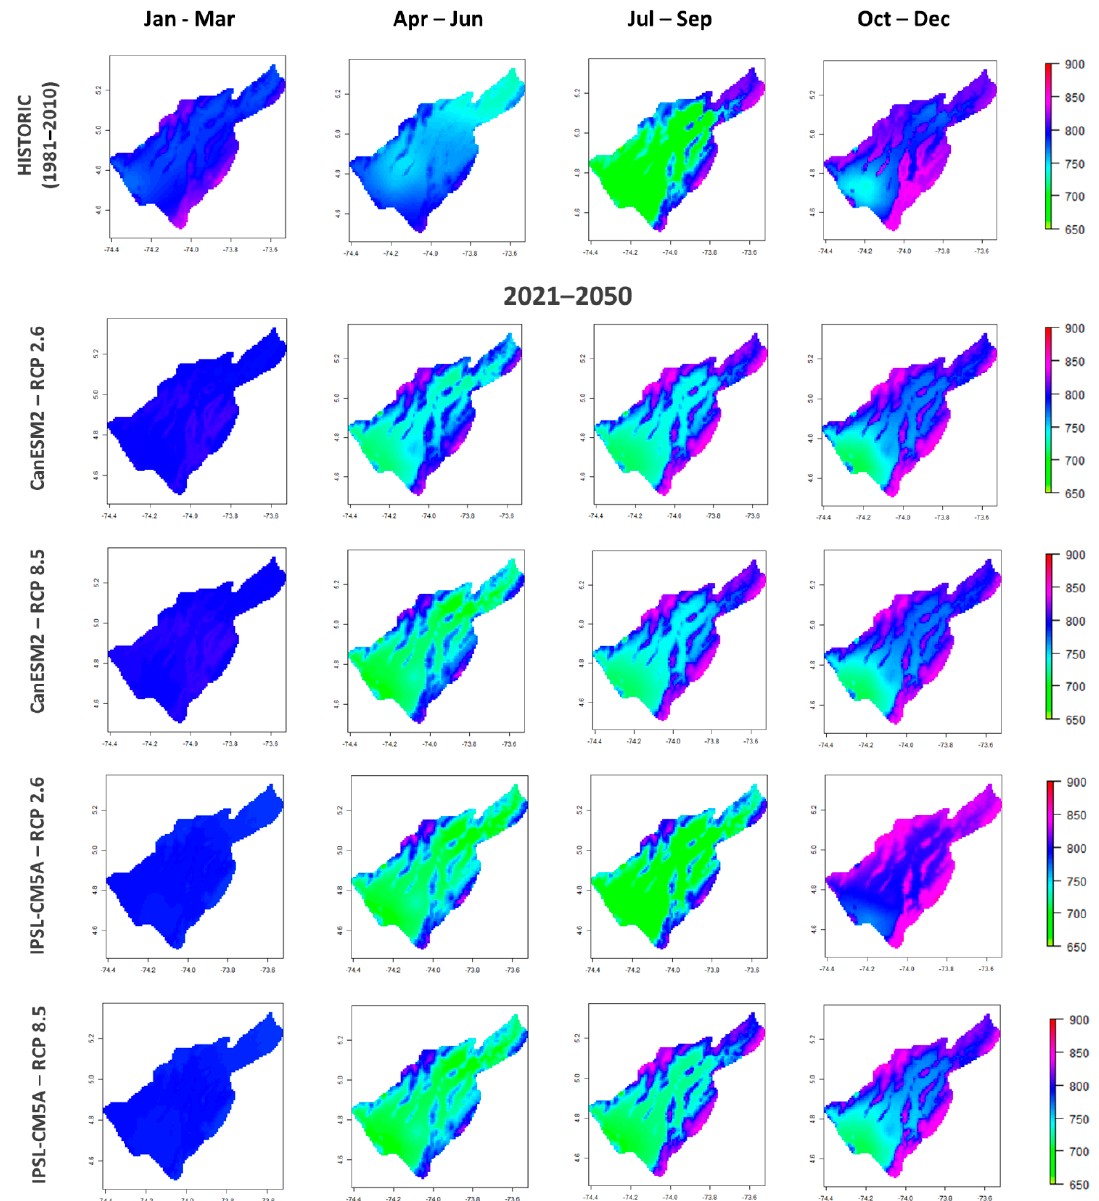
Figure B7. Soil Moisture 2021–2050 Figure A11. Soil Moisture